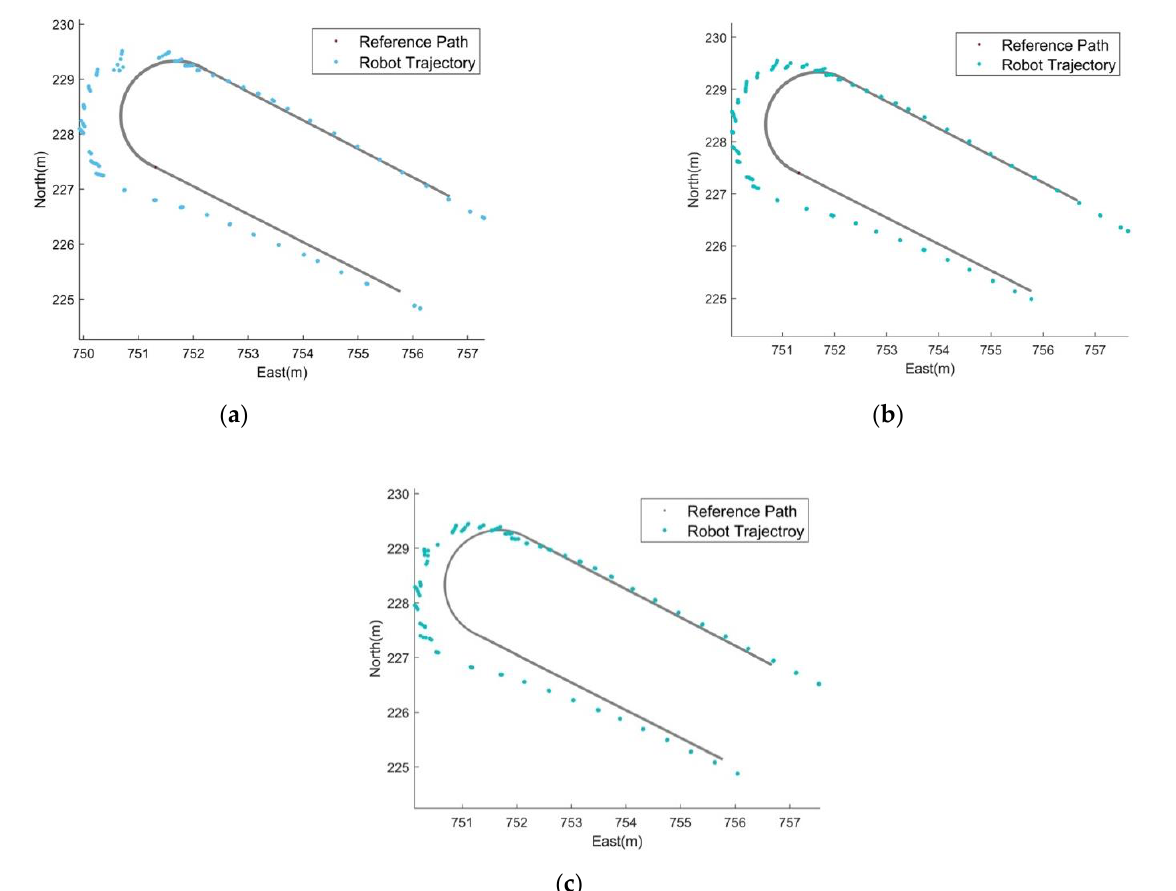
Figure 15. Robot trajectories during the test. ( a ) Test 1; ( b ) Test 2; ( c ) Test 3.